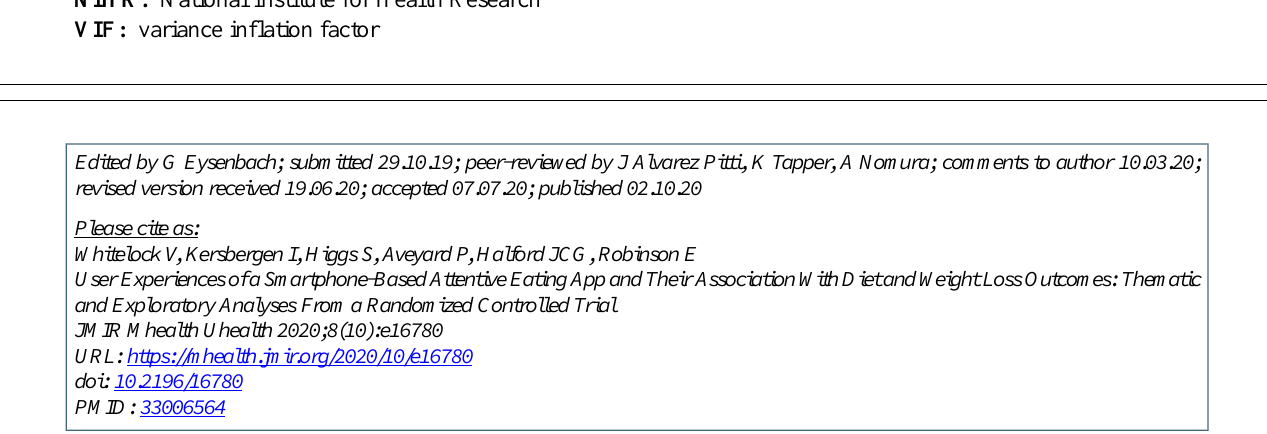
NIHR: National Institute for Health